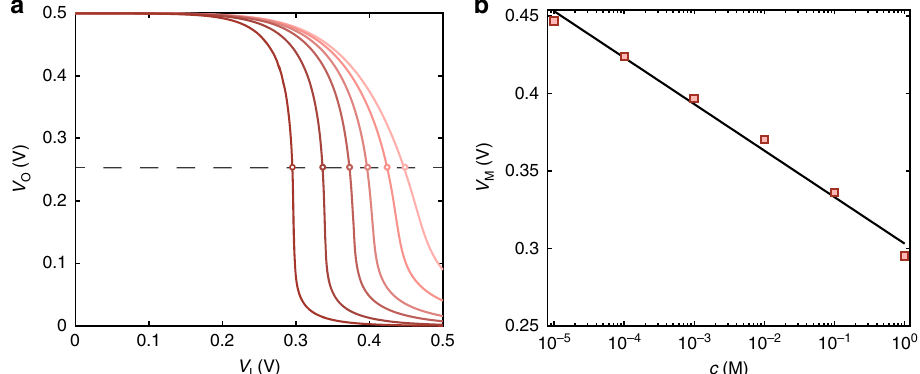
Fig. 2 Wide range operation. a Measured (thick red lines) transfer characteristics of the organic electrochemical transistor complementary ampli fi er at various ion concentrations. From the rightmost to the leftmost characteristic the ion concentration is equal to [10 − 5 , 10 − 4 , 10 − 3 , 10 − 2 , 10 − 1 , 1] M. b Measured V M as a function of c (square symbols). A sensitivity equal to S M = 30 mV dec − 1 is obtained with the least square linear approximation (solid line) of the